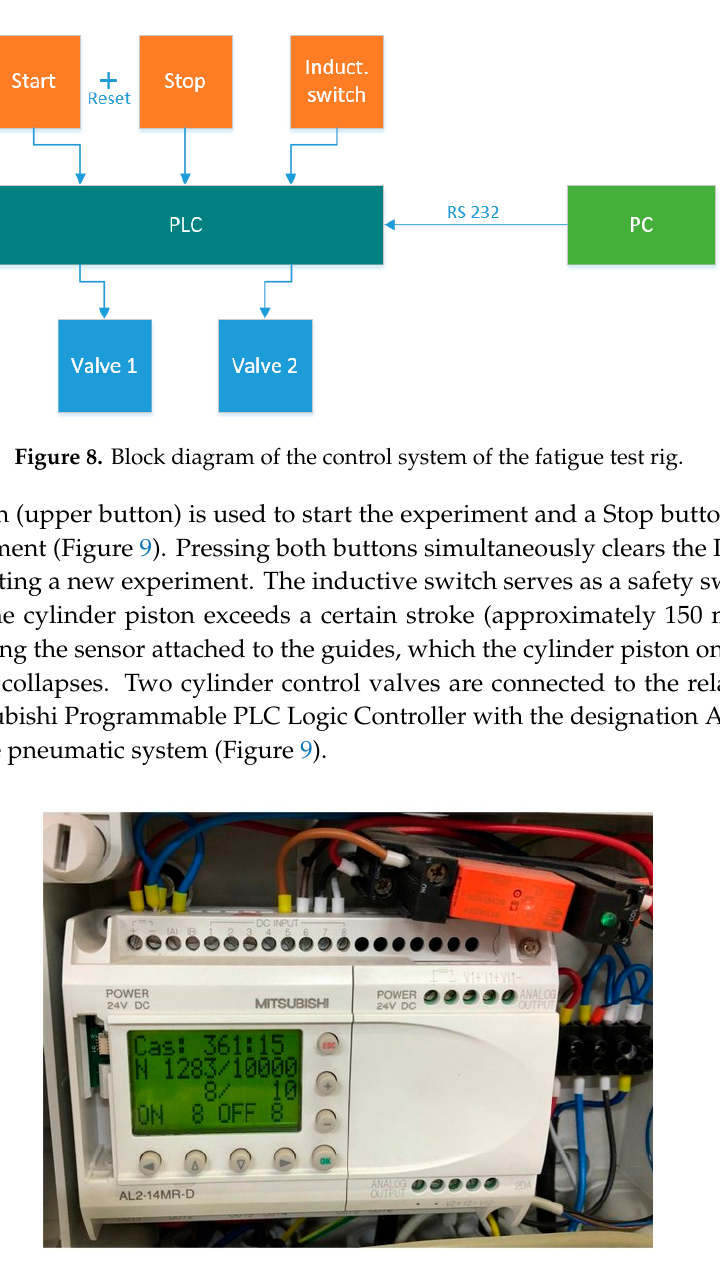
Figure 9. Mitsubishi Alpha2 PLC.